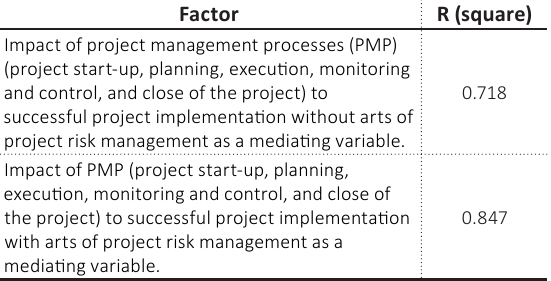
Table 4. R-squared value